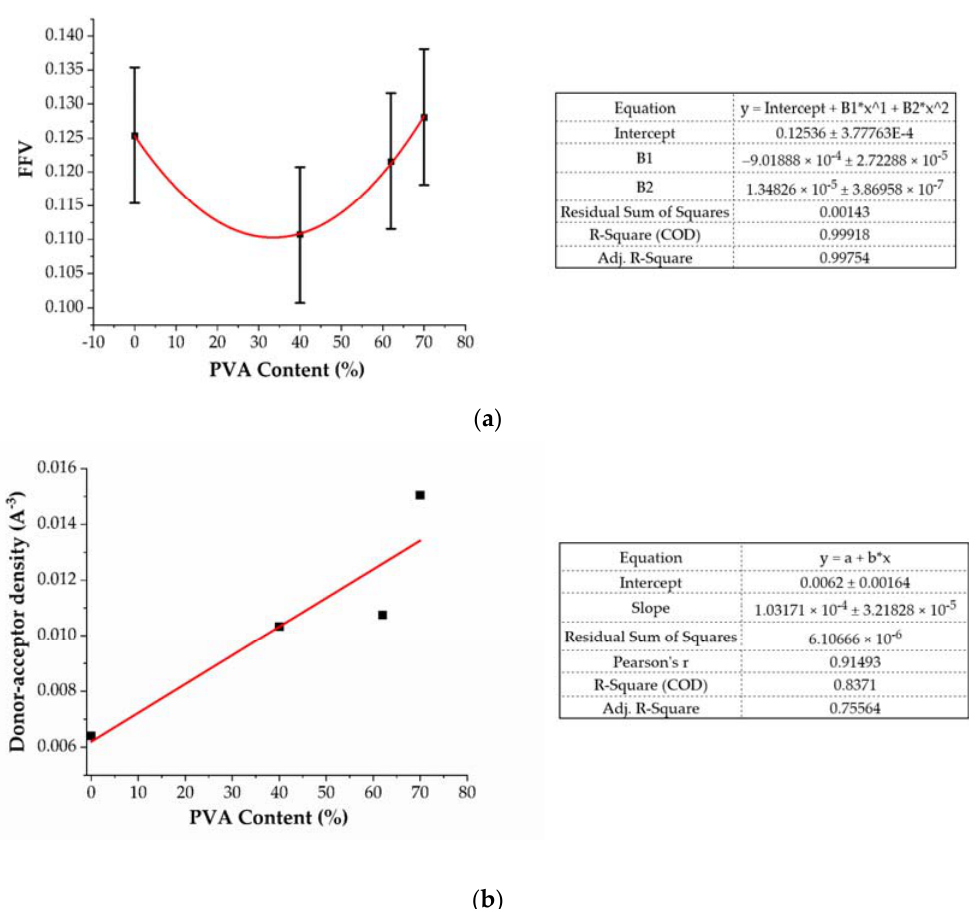
Figure 10. FFV ( a ) and hydrogen bond donor–acceptor density ( b ) depending on the PVA content in the gelatin/PVA blend.